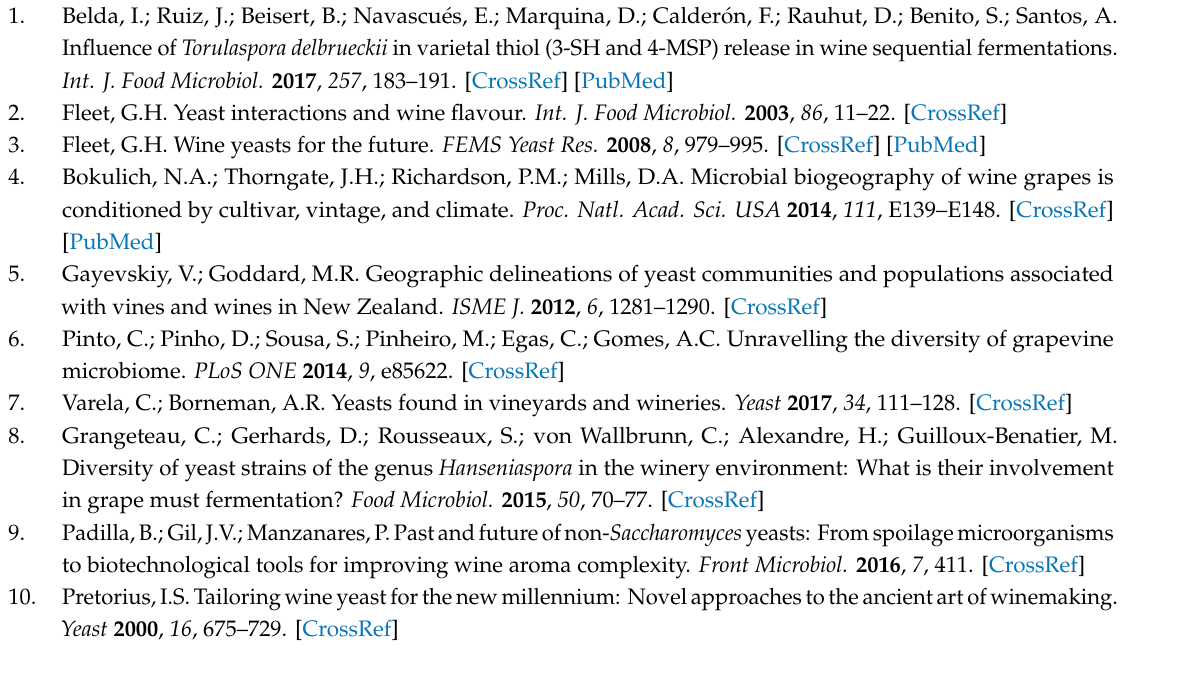
Figure S1: Representative image of DNA patterns of selected M. pulcherrima strains isolated from Port wine must samples, generated by RAPD-PCR analysis with the oligonucleotide M14. Figure S2: Cluster analysis of H. uvarum strains isolated from Port wine must samples fermented with Touriga Franca grape variety; Figure S3: Cluster analysis of H. uvarum strains isolated from Port wine must samples fermented with Touriga Nacional grape variety.; Figure S4: Cluster analysis of L. thermotolerans strains isolated from Port wine must samples.; Figure S5: Cluster analysis of M. pulcherrima strains isolated from Port wine must samples.; Figure S6: Heatmaps representing the growth performance of non- Saccharomyces strains isolated from Port wine must samples on stress conditions associated with alcoholic fermentation. Table S1: Details of must samples used in the study.; Table S2: Growth of selected non-Saccharomyces species isolated from Port wine must samples on stress conditions associated with alcoholic fermentation.; Table S3: Quantification of metabolite for selected non-Saccharomyces species isolated from Port wine must